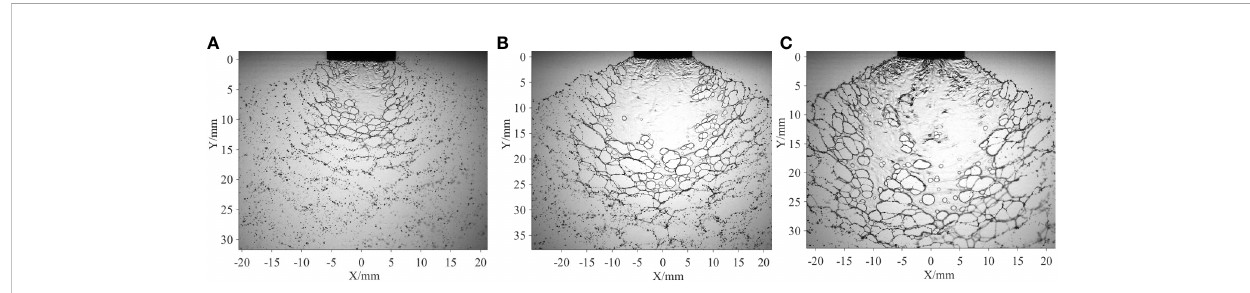
FIGURE 9 Spray sheets for different nozzles. The spray pressure is 0.3 MPa, and the volumetric concentration of the oil-based emulsion is 0.1%. (A) ST-110-01 (B) ST-110-03 (C)